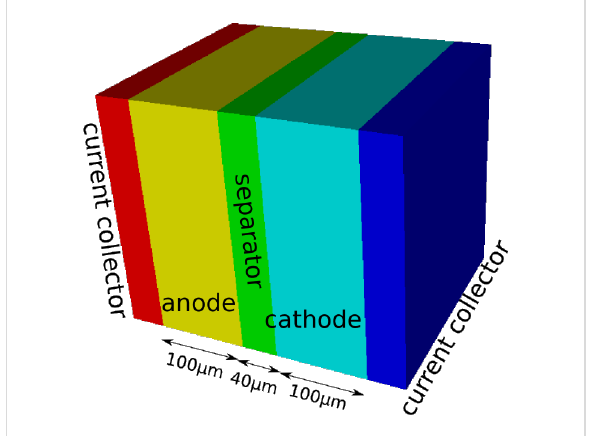
Figure 2: Geometry for mesoscopic simulations with the porous-elec- trode model.